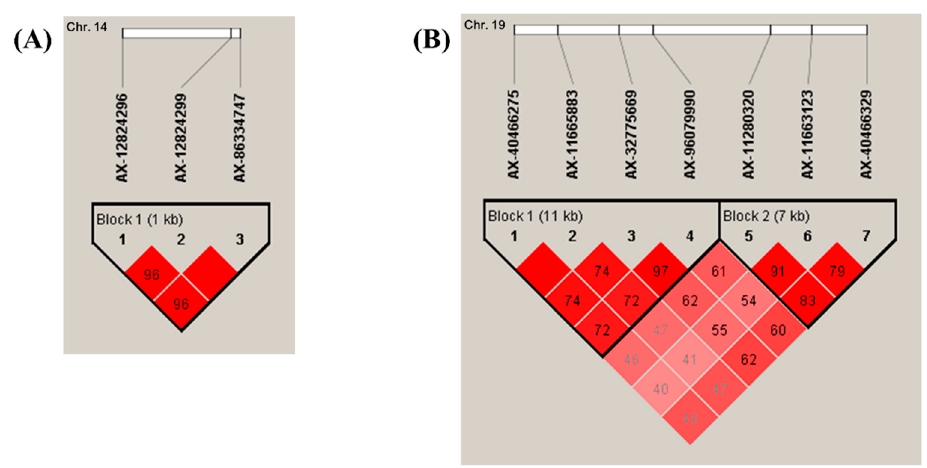
Figure 3. Linkage disequilibrium (LD) structure identified in chromosomes 14 and 19. ( A ) LD block located on the adjacent region of the JDP2 and BATF genes on chromosome 14. ( B ) LD blocks located on the adjacent region of the KLK4 gene on chromosome 19. The color gradient indicates values of LD.